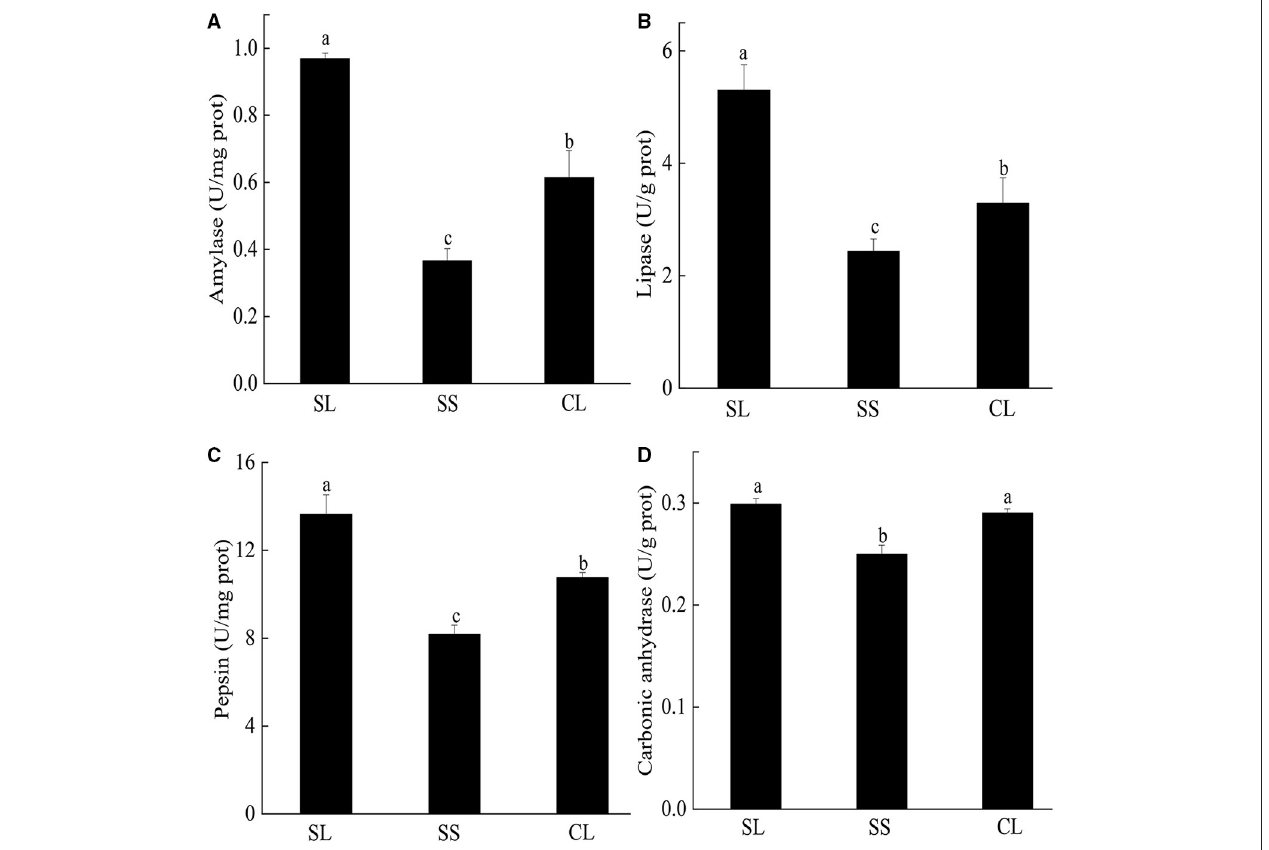
FIGURE 4 | (A–D) Specific activities of amylase, pepsin, lipase, and carbonic anhydrase activities in the visceral mass of P. f. martensii . Means ± S.D. are presented. n = 3 replicate per treatment. Different letters represent significant differences ( p <